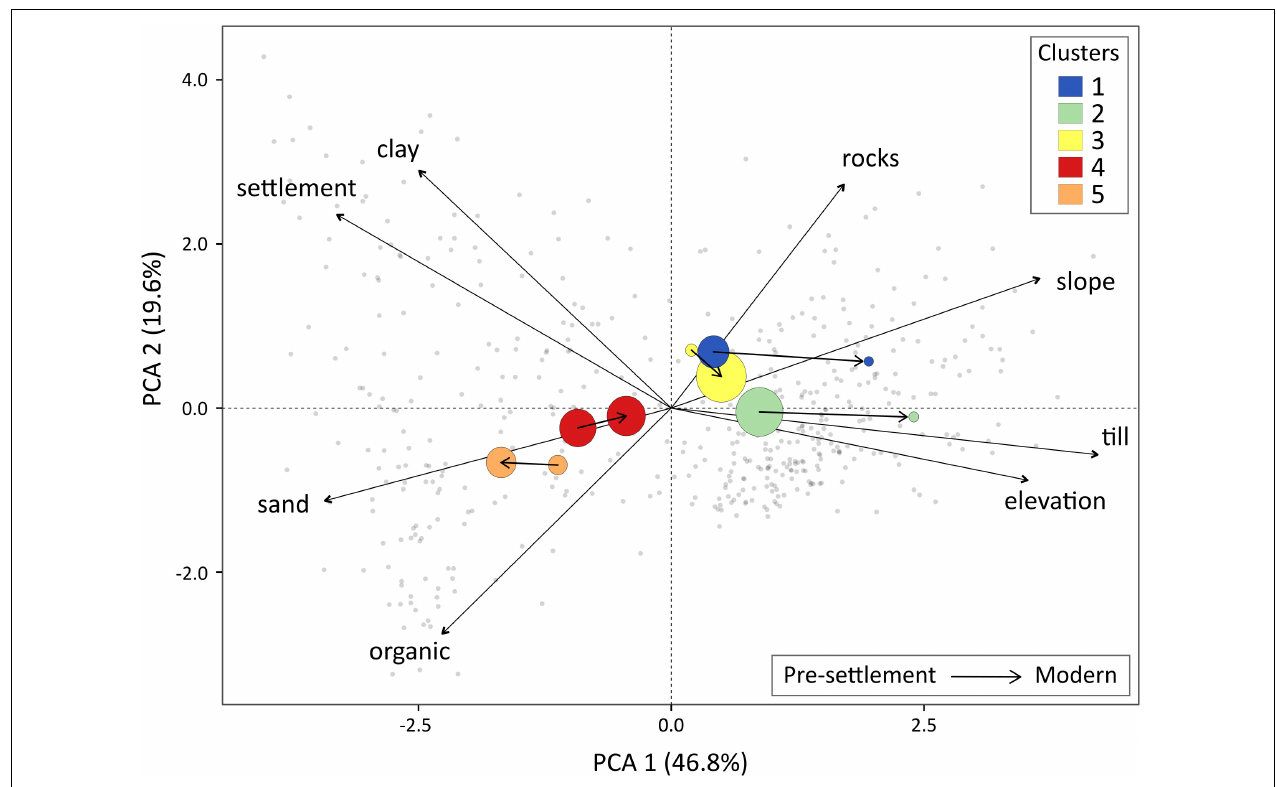
FIGURE 5 | Principal component analysis (PCA) where axes 1 and 2 explain 46.8% and 19.6% of the environmental variability, respectively. Biplot shows cell scores (grey dots), correlations of environmental variables with axes 1 and 2, and clusters (circles) for both time periods as the centroids of the corresponding cell scores. Circles size is proportional to the corresponding number of cells in each cluster. Arrows between clusters show the transition from pre-settlement to modern periods. PCA1 mainly represents the plains on the left, where clay and sandy deposits are predominant, and the uplands on the right, where glacial till is abundant and settlement is absent. PCA2 is more associated with soil texture and reflects more subtle differences among